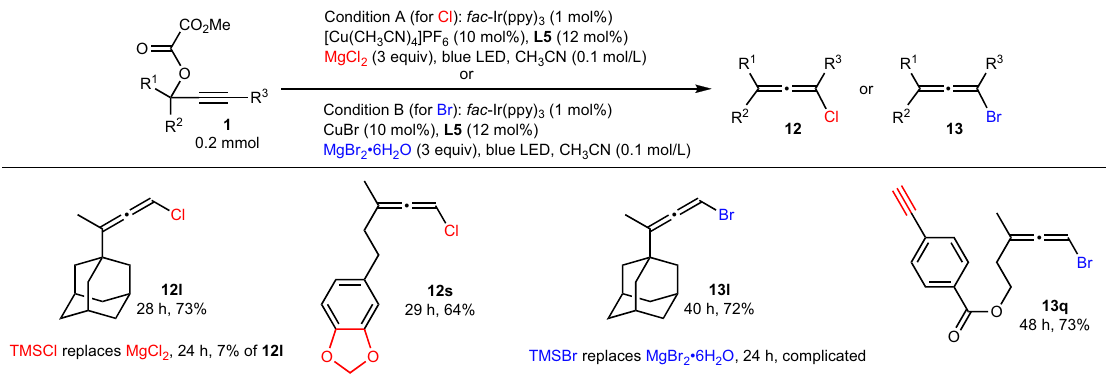
Fig. 3 Reaction with MgCl 2 or MgBr 2 • 6H 2 O instead of TMSCN. The reaction condition A was used for the synthesize of cholorallenes (present in red color), and the reaction condition B was used for the synthesize of bromoallenes (present in blue color).